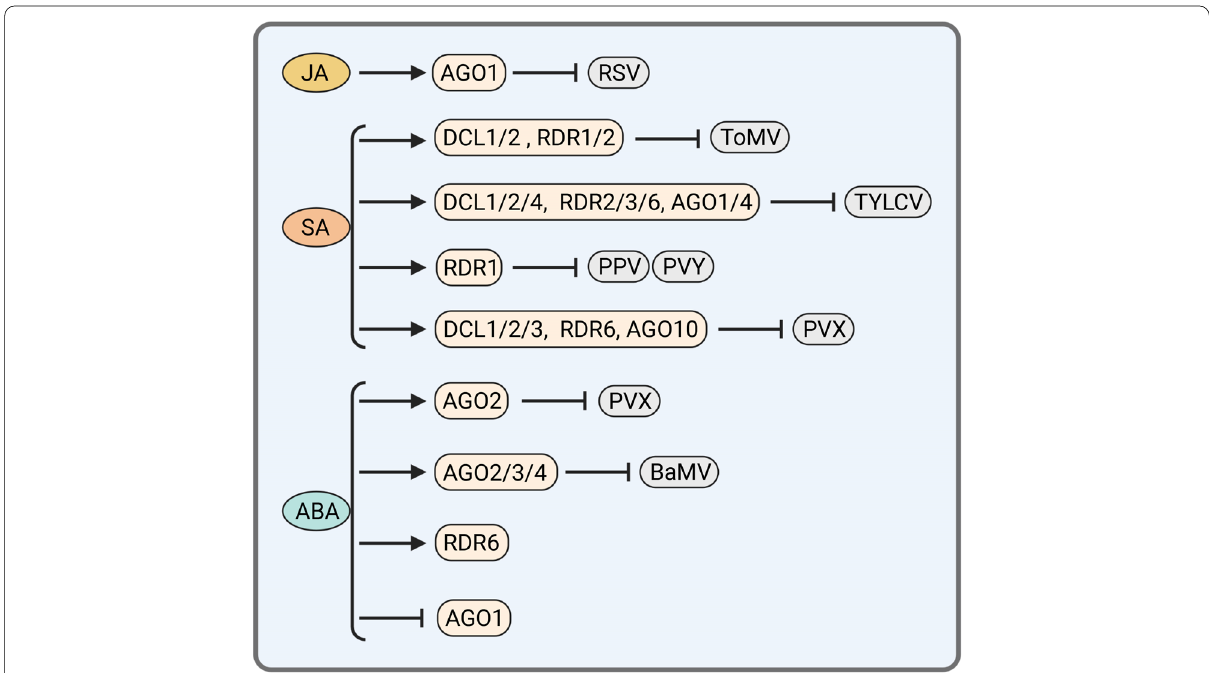
Fig. 2 The roles of plant hormones in RNAi-related gene expression during virus infection. The plant hormones shown in ovals generally have positive or negative effects on different RNAi-related gene expression. Correlation among hormones, RNAi-related key genes, and viruses are shown. Arrow and T-sign indicate positive or negative impact,